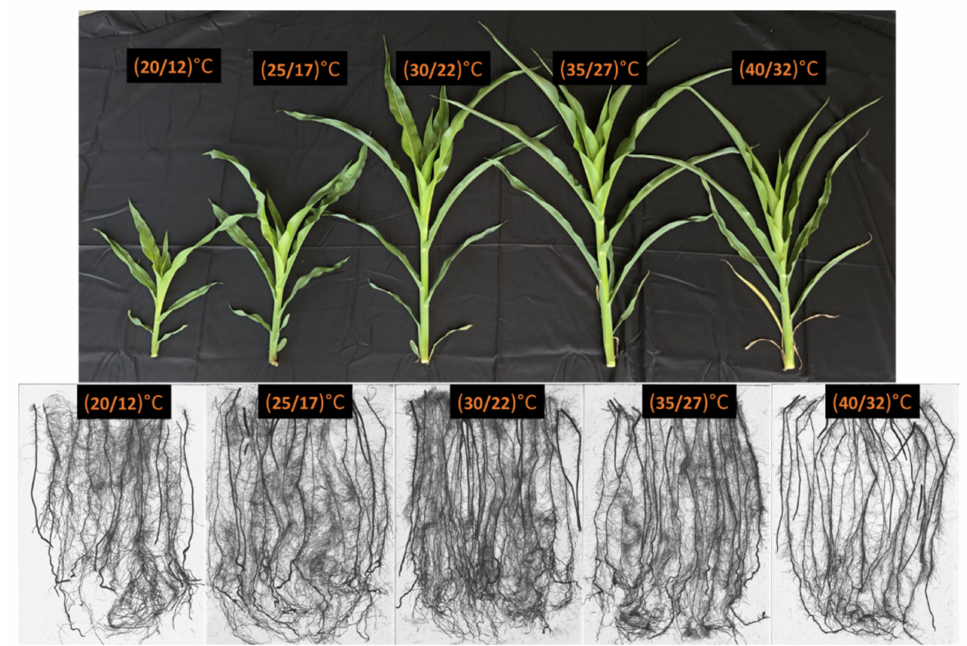
Figure 2. Pictorial representation of corn shoot and root growth under five temperature treatments harvested 21 days after treatment or 26 days after sowing.